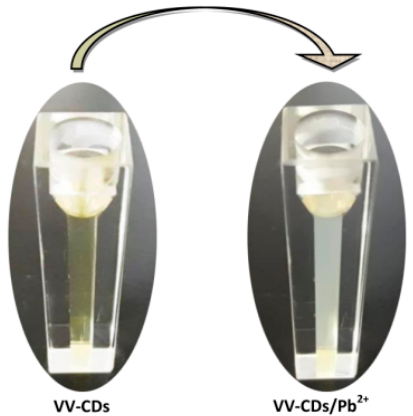
Figure 6. VV-CDs solution without and with the addition of 1000 μ M Pb 2+ ions.